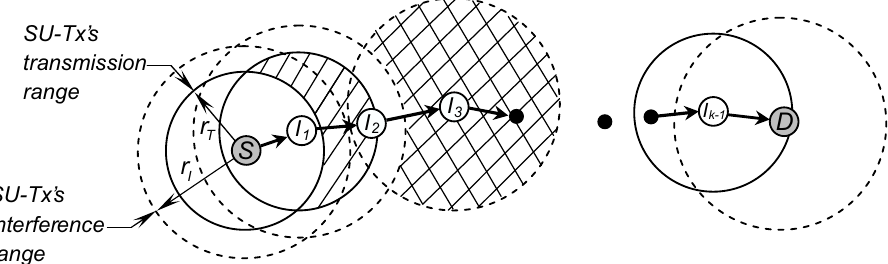
Figure 4. Multi-hop connectivity between two secondary users (SUs) in